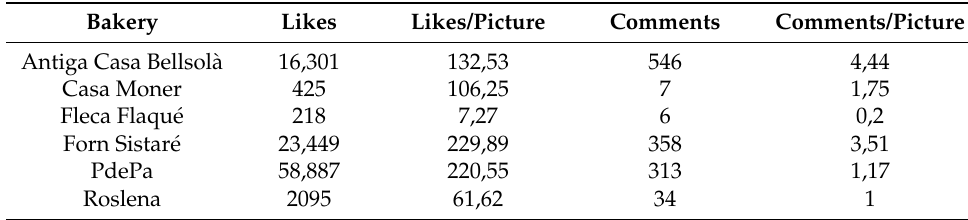
Table 3. Likes and comments of bakeries’ posts on